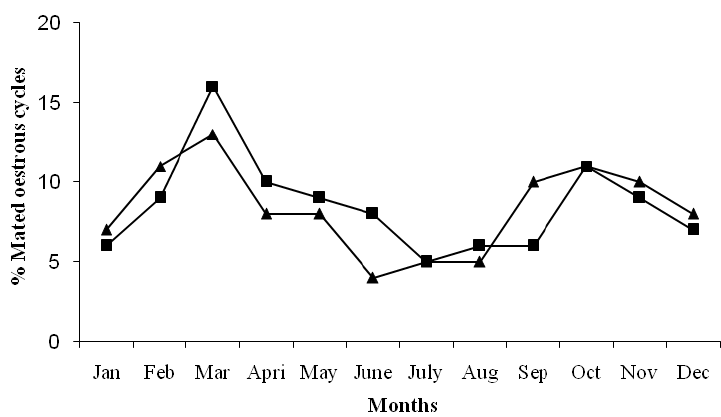
Figure 1. Distribution of mares mated during the whole year. Shown are the % of mares mated oestrous cycles ( n = 697) of Arabian (▲) and ( n = 1,110) of Thoroughbred (■) mares under subtropical conditions of